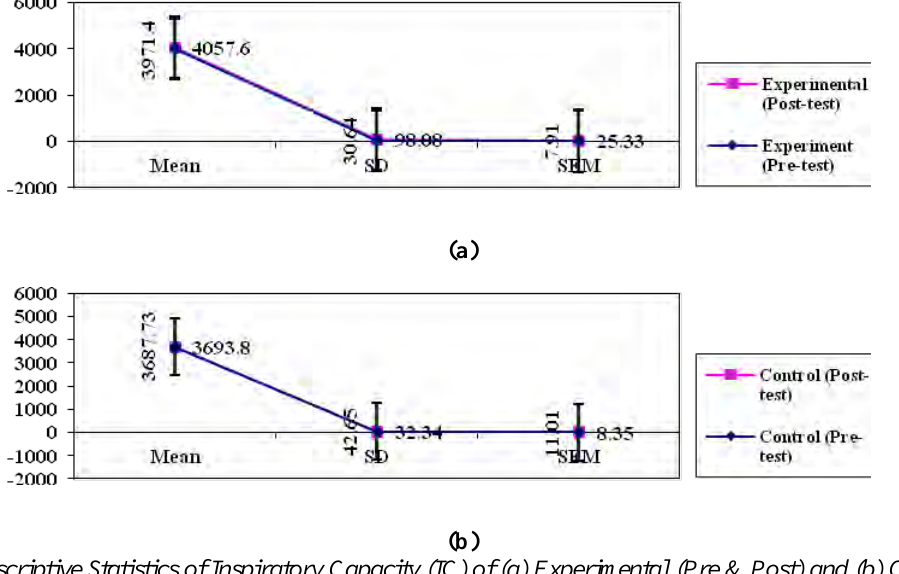
Fig. 12. Descriptive Statistics of Inspiratory Capacity (IC) of (a) Experimental (Pre & Post) and (b) Control (Pre & Post) group of University Level